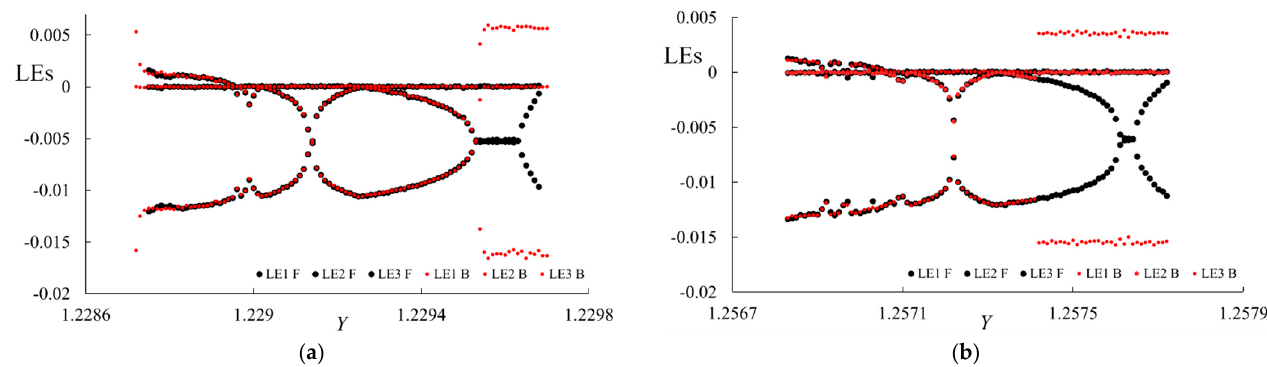
Figure 3. LEs are graphed as a function Y . Lyapunov spectra are plotted in the forward (black) and backward (red) scans for ( a ) WI and ( b ) WII. Note, the regions where red and black dots do not override each other.